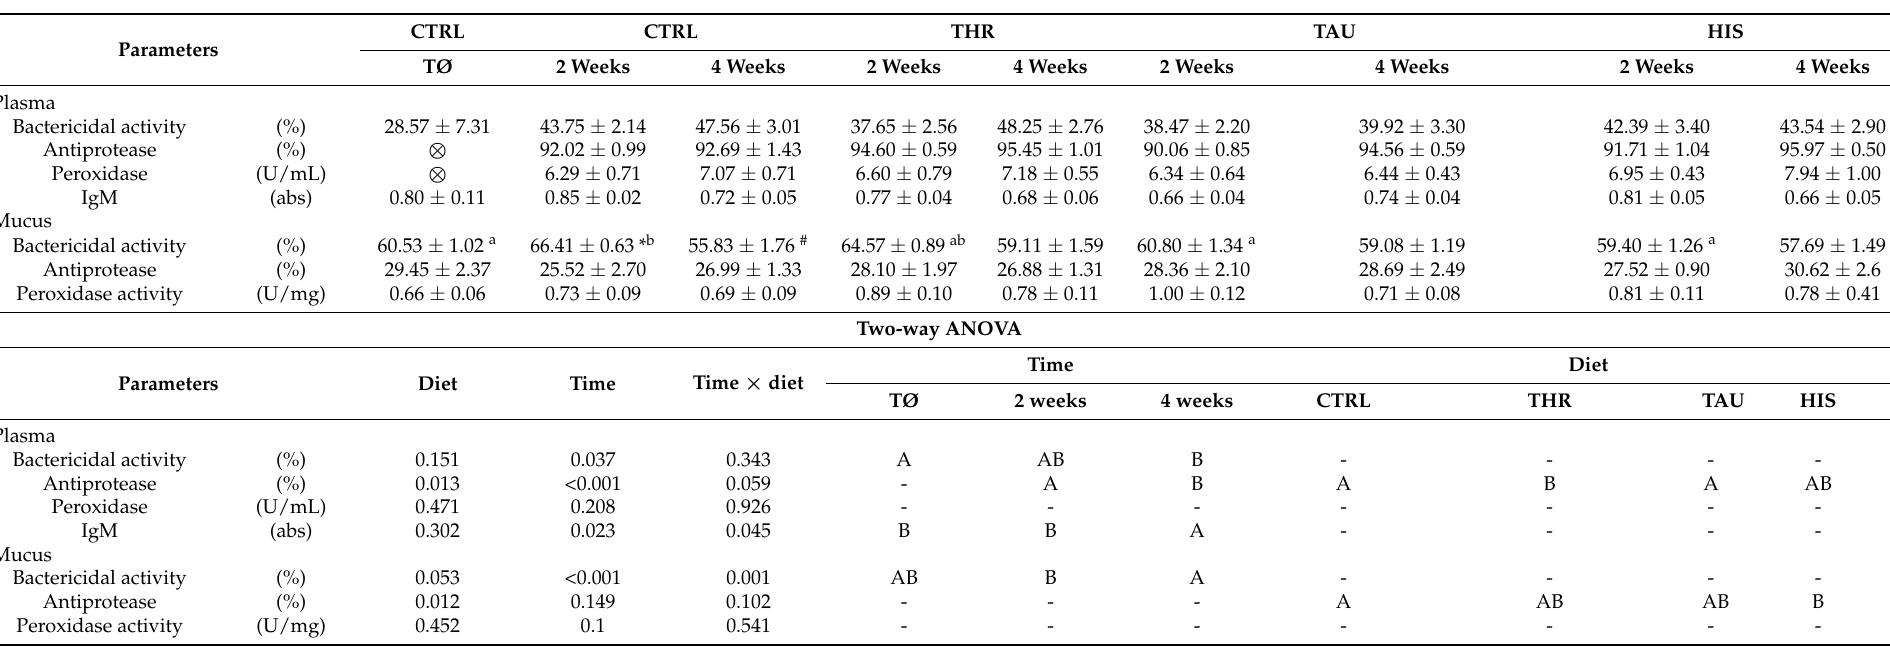
Table 6. Plasma and mucus humoral parameters of gilthead seabream fed dietary treatments during two and four